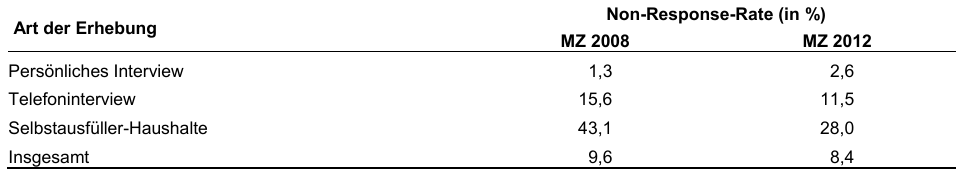
Tabelle 3 : Non-Response-Rate zur Frage nach geborenen Kindern in MZ 2008 und